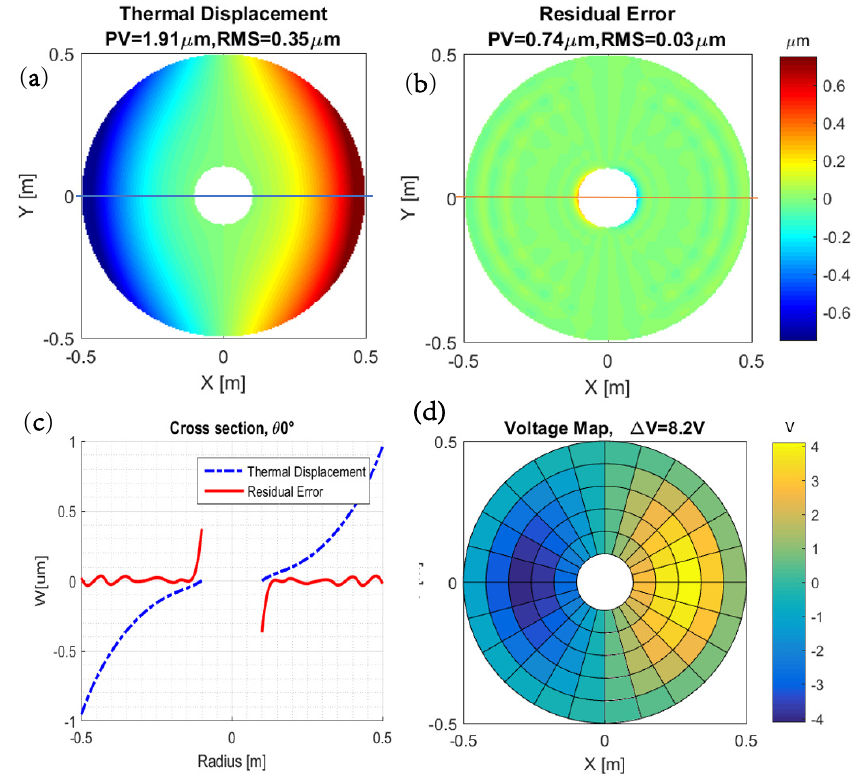
Figure 8. Effect of a thermal gradient of ∓ 15 ◦ K on the full reflector with balanced layer design and near zero CTE substrate ( a ) Thermal displacements along z without control. ( b ) Residual displacements after control. ( c ) Cross section at 30 ◦ of the displacements before (blue) and after control (red). ( d ) Map of the correcting voltages.